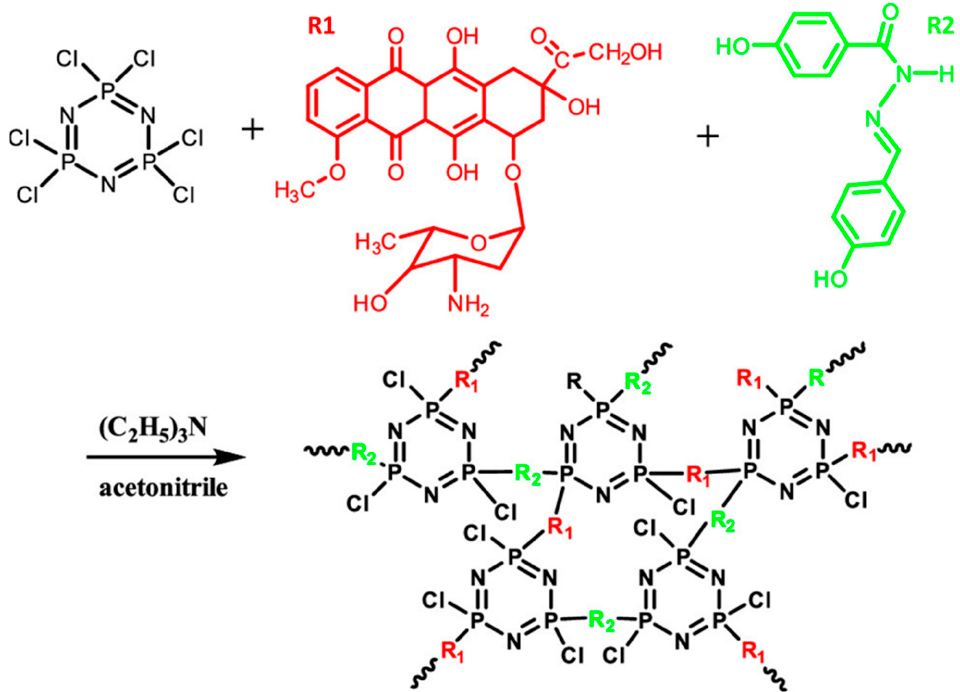
Figure 3. Synthesis route for cross-linked PPZ nano-drugs. Adapted and reused with permission from [38], 2020, American Chemical Society.